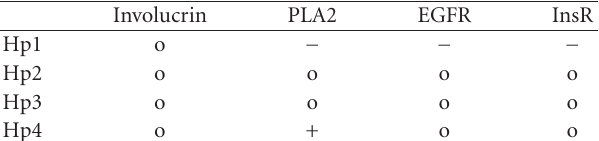
Table 4: Gene expression of NHEK after 6h of incubation with 10 μ g/mL St. John’s Wort polysaccharides in serum-starved media. Results of RT-PCR with TaqMan Assays were normalized to endogenous control 18srRNA and to respective target gene expression of untreated control cells. Regulation was defined as